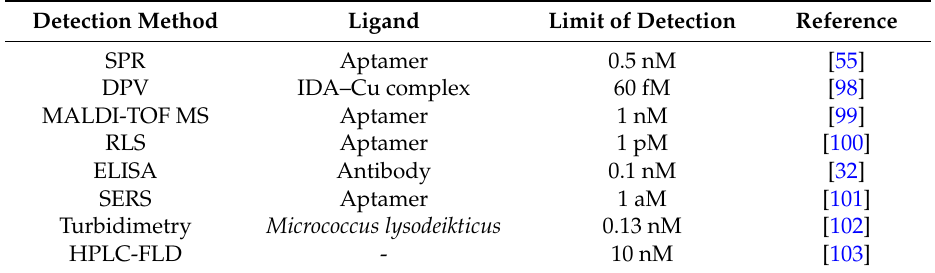
Table 3. Sensitivity of methods besides aptamer-based electrochemical ones for the detection of